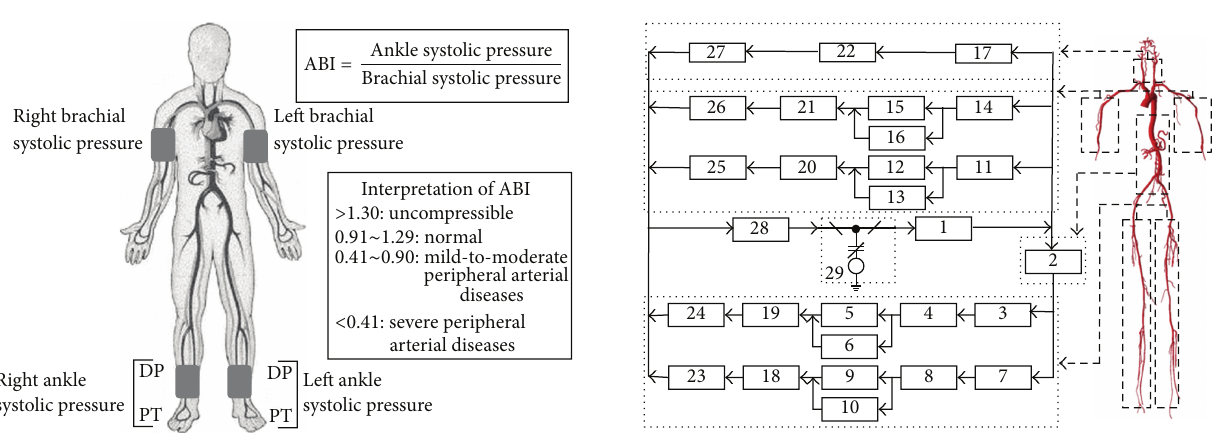
Figure 1: Measurement of the ankle-brachial index (ABI). DP indicates dorsalis pedis artery; PT, posterior tibial artery.